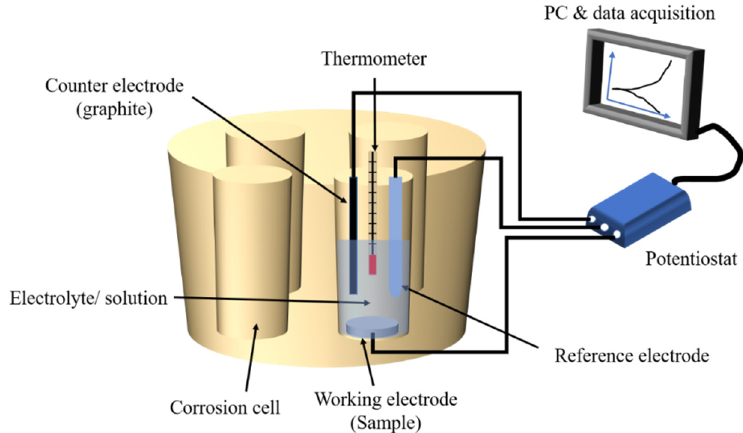
Figure 1. Schematic diagram of the electrochemical set-up.